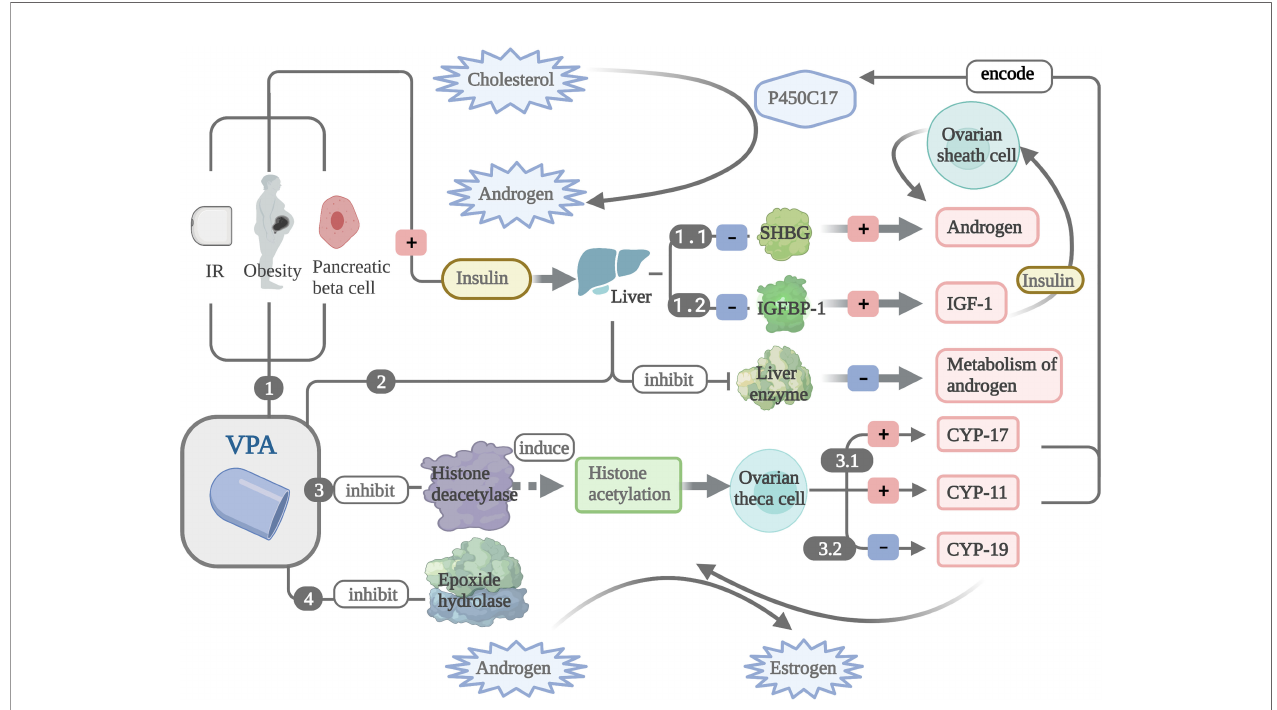
FIGURE 2 | The mechanism of valproate (VPA) leading to increased level of androgen. 1.1 VPA can lead to hyperinsulinemia by inducing insulin resistance (IR) and weight gain and directly acting on pancreatic islet B cells, and then excessive insulin could hinder the synthesis of sex hormone binding globulin (SHBG) to elevate the level of androgen. 1.2 Insulin inhibits the production of insulin-like growth factor 1 binding protein (IGFBP-1) and increases the availability of (IGF-1). Insulin and IGF-1 increase the synthesis of androgen. 2 VPA can reduce the metabolism of androgens in the liver and increase androgen levels. 3.1 VPA potentiates androgen biosynthesis by promoting CYP11 and CYP17 gene expressions, encoding the P450 enzyme that participates in the conversion of cholesterol to androgen. 3.2 VPA also inhibits the expression of the CYP19 gene encoding P450 aromatase to reduce the conversion of androgens to estradiol. 4 VPA can inhibit the activity of epoxidation hydrolase, which may also be involved in the conversion of androgens to